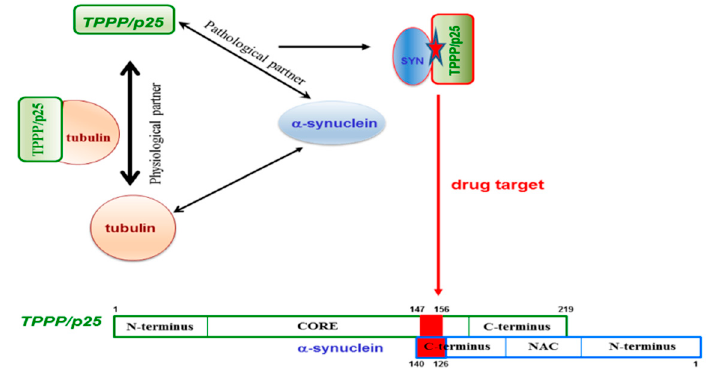
/ p25–SYN complex as a specific drug